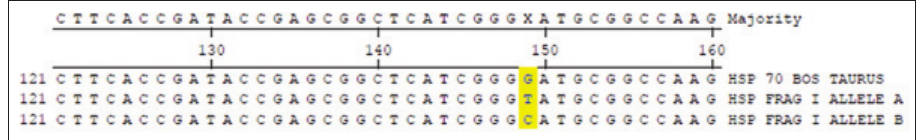
Figure-2: Sequence alignment of Fragment I of heat shock protein 70 gene.